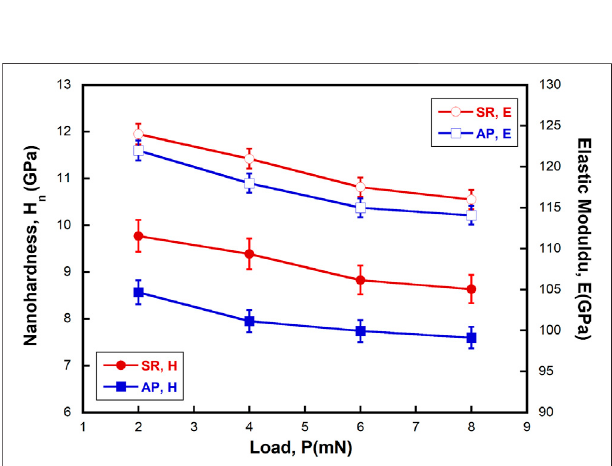
FIGURE 1 | X-ray diffraction patterns of the SR and AP NGs displaying the amorphous nature of the